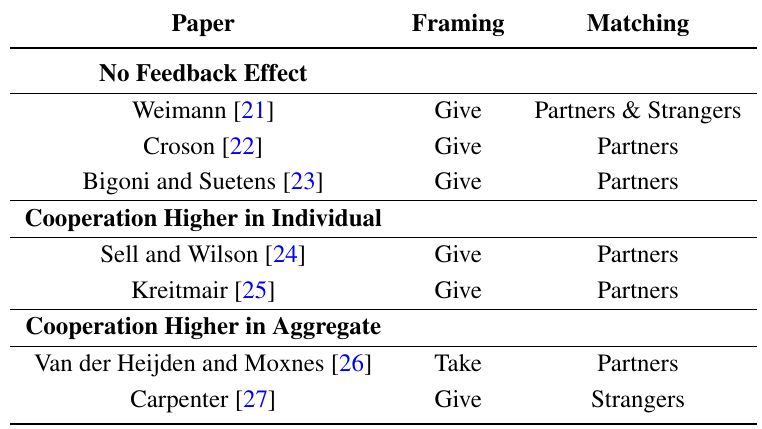
Table 2. Summary of Experiments on Individual/Aggregate Feedback in Linear VCM